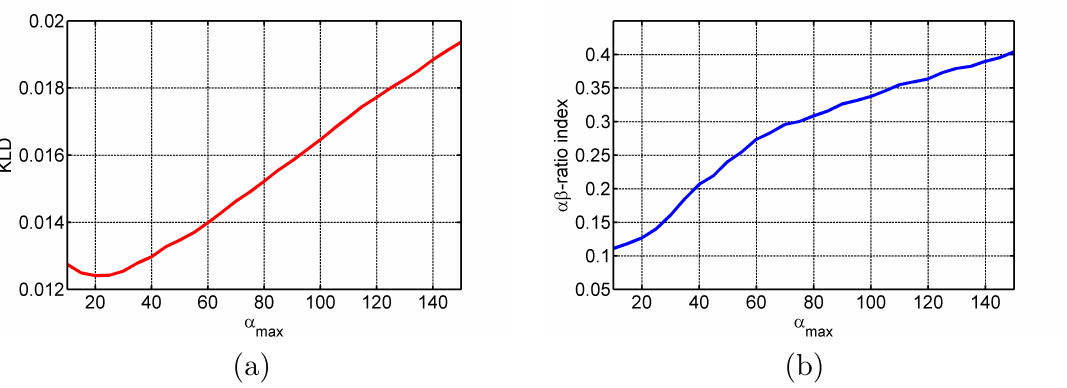
Figure 6. Rome test case: evolution of: ( a ) the KLD parameter and ( b ) the αβ -ratio index, as a function of the α max variation for the EWF